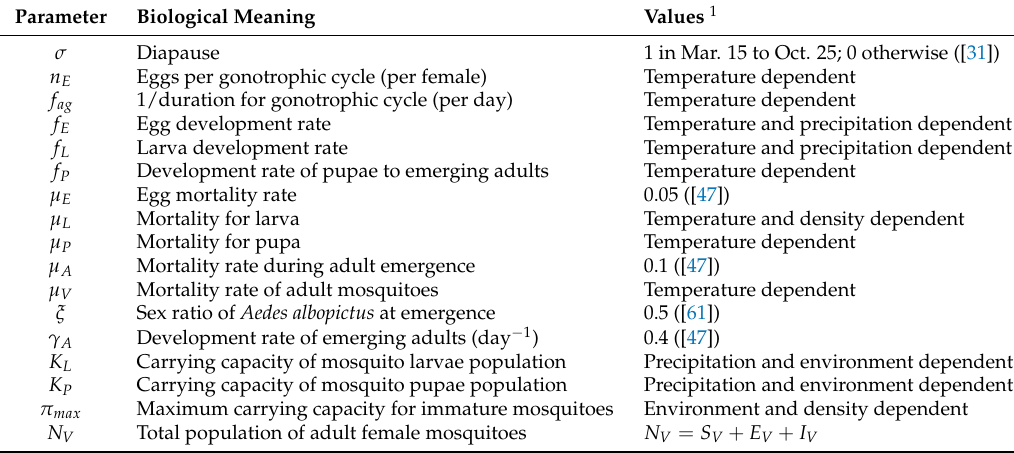
Table 2. Parameter notation, biological meaning and values used in the extended